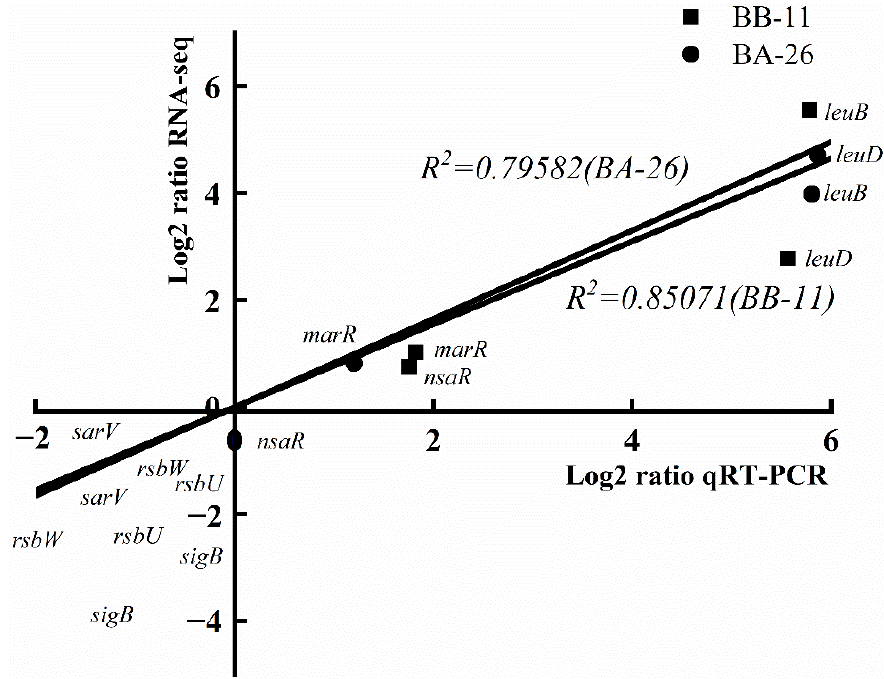
Figure 9. qRT–PCR validation. The x -axis indicates the log2 fold change obtained using RNA-seq analysis; the y -axis indicates the log2 fold change obtained using qRT–PCR.